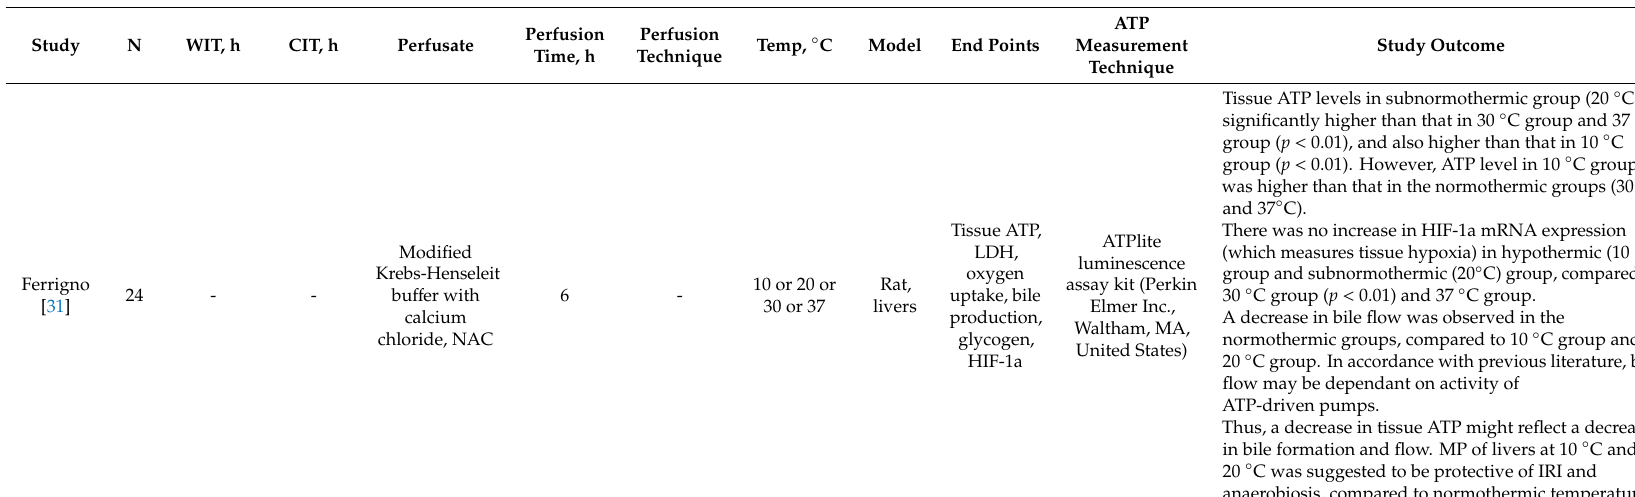
Table 5. Characteristics and outcomes of key pre-clinical and animal studies investigating the relationship of metabolism and di ff erent perfusion temperatures in the